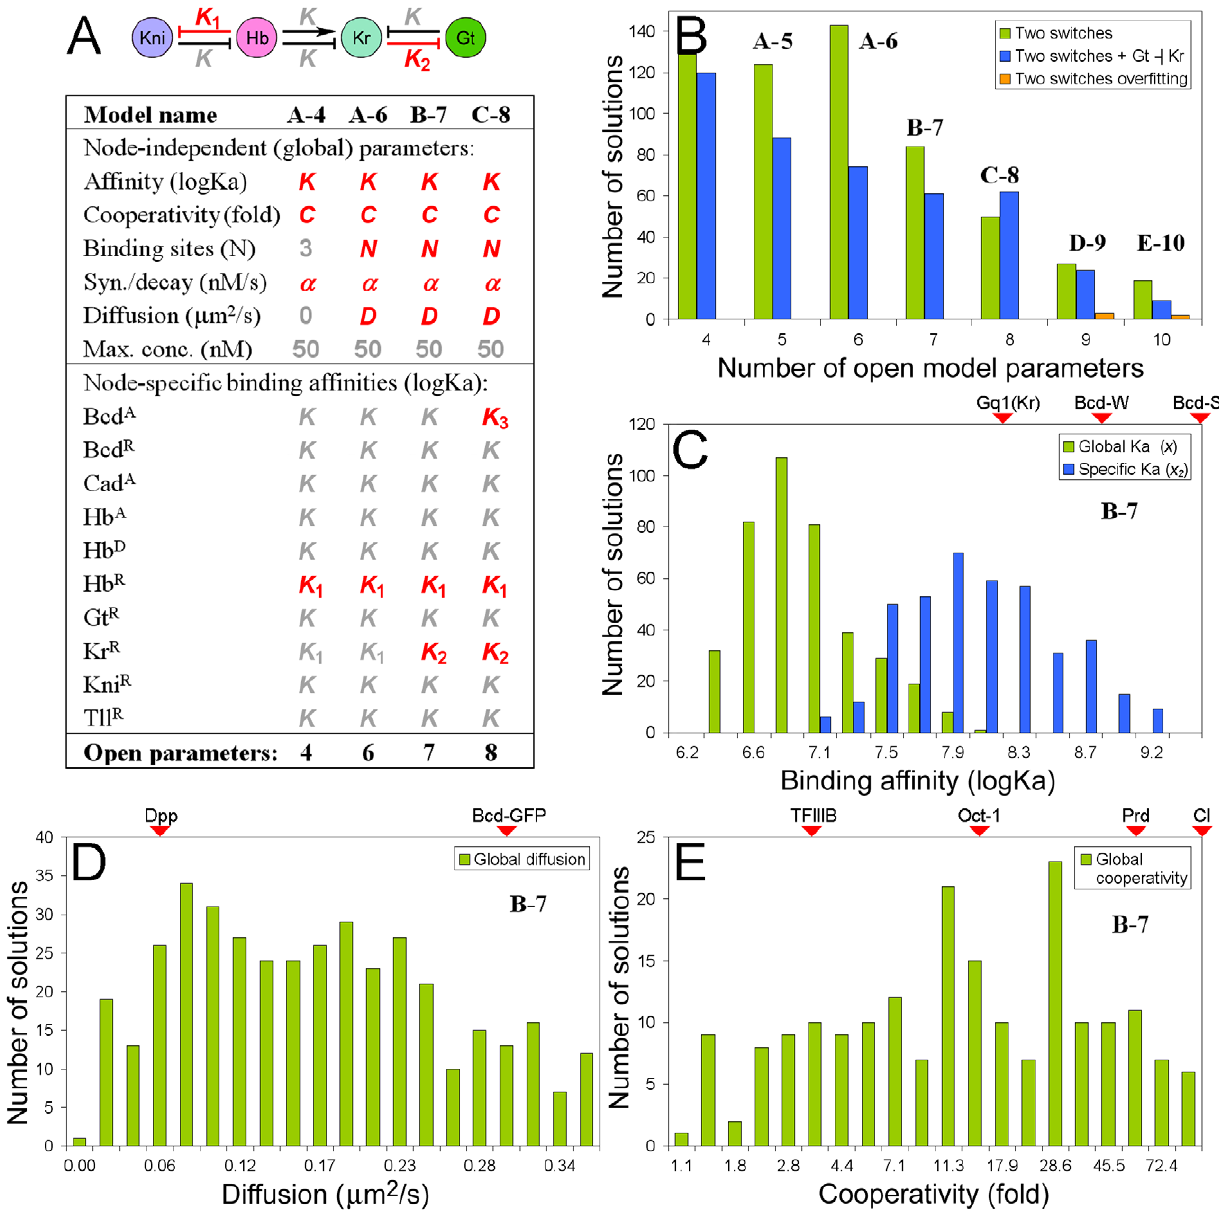
Figure 3. Model design, performance and solution ranges. (A) The number of open for optimization parameters (in red) incorporated into the model. The global parameters included binding affinity, cooperativity, number of binding sites, synthesis, decay and diffusion rates and maximal absolute concentration. Node-specific parameters included binding affinities, different from the global K for some regulatory connections ( K 1 , K 2 , K 3 , see the network above). (B) Performance of different models. The explored network with 2 toggle switches performed similarly to the same network plus one link connecting the switches. With more than 8 open parameters, the two-switch model fitted incorrect data (swapped Kr and Kni expression data). (C) Values of global ( K ) and specific ( K 2 ) binding affinity constants from solutions for B-7 model. Markers show known binding affinities for some transcription factors [47,48]. (D) Values of diffusion for B-7 model. Red triangles on top (markers) show some known diffusion rates [45,46]. (E) Cooperativity values from solutions for B-7 model, markers show some known cooperativity values